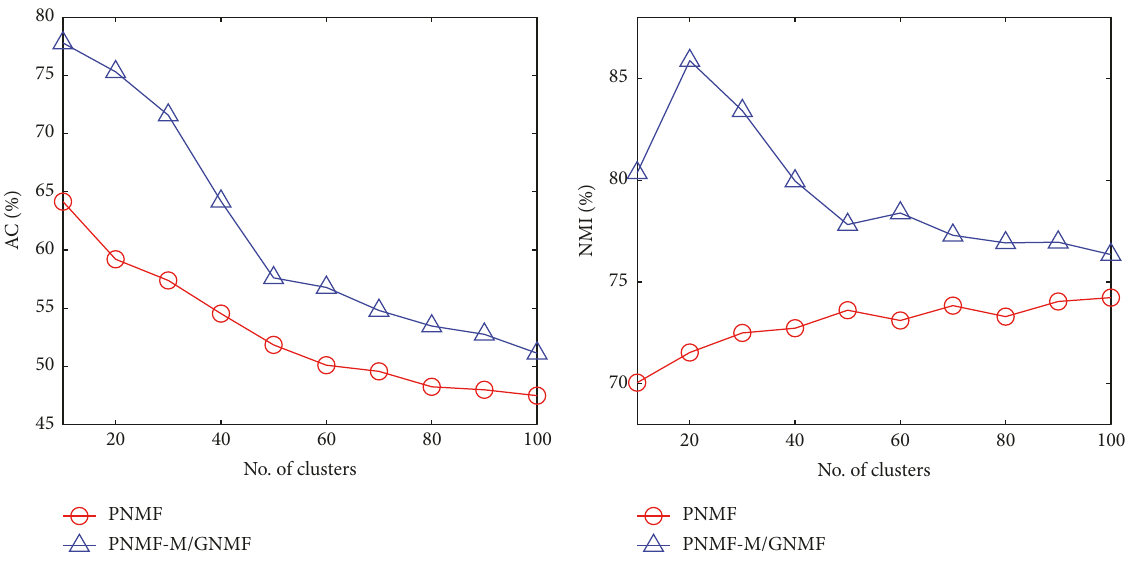
Figure 7: AC and NMI on COIL100.